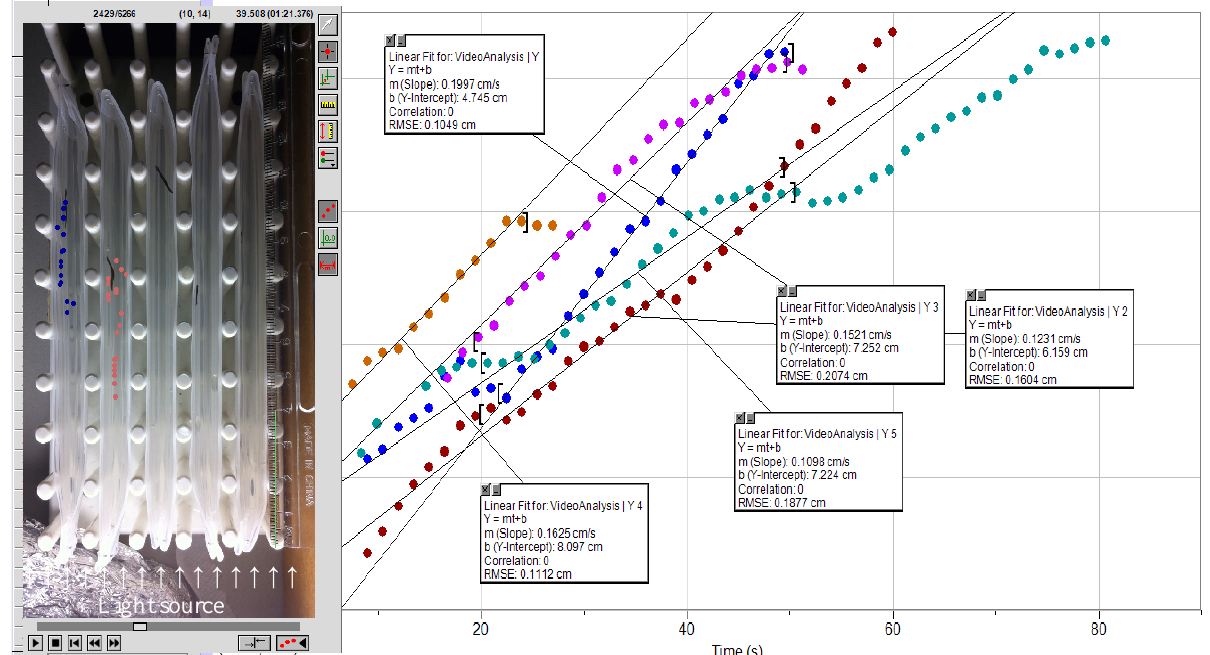
Figure 1. Test apparatus and principle of average velocity determination from videotaped experiments by using tracking